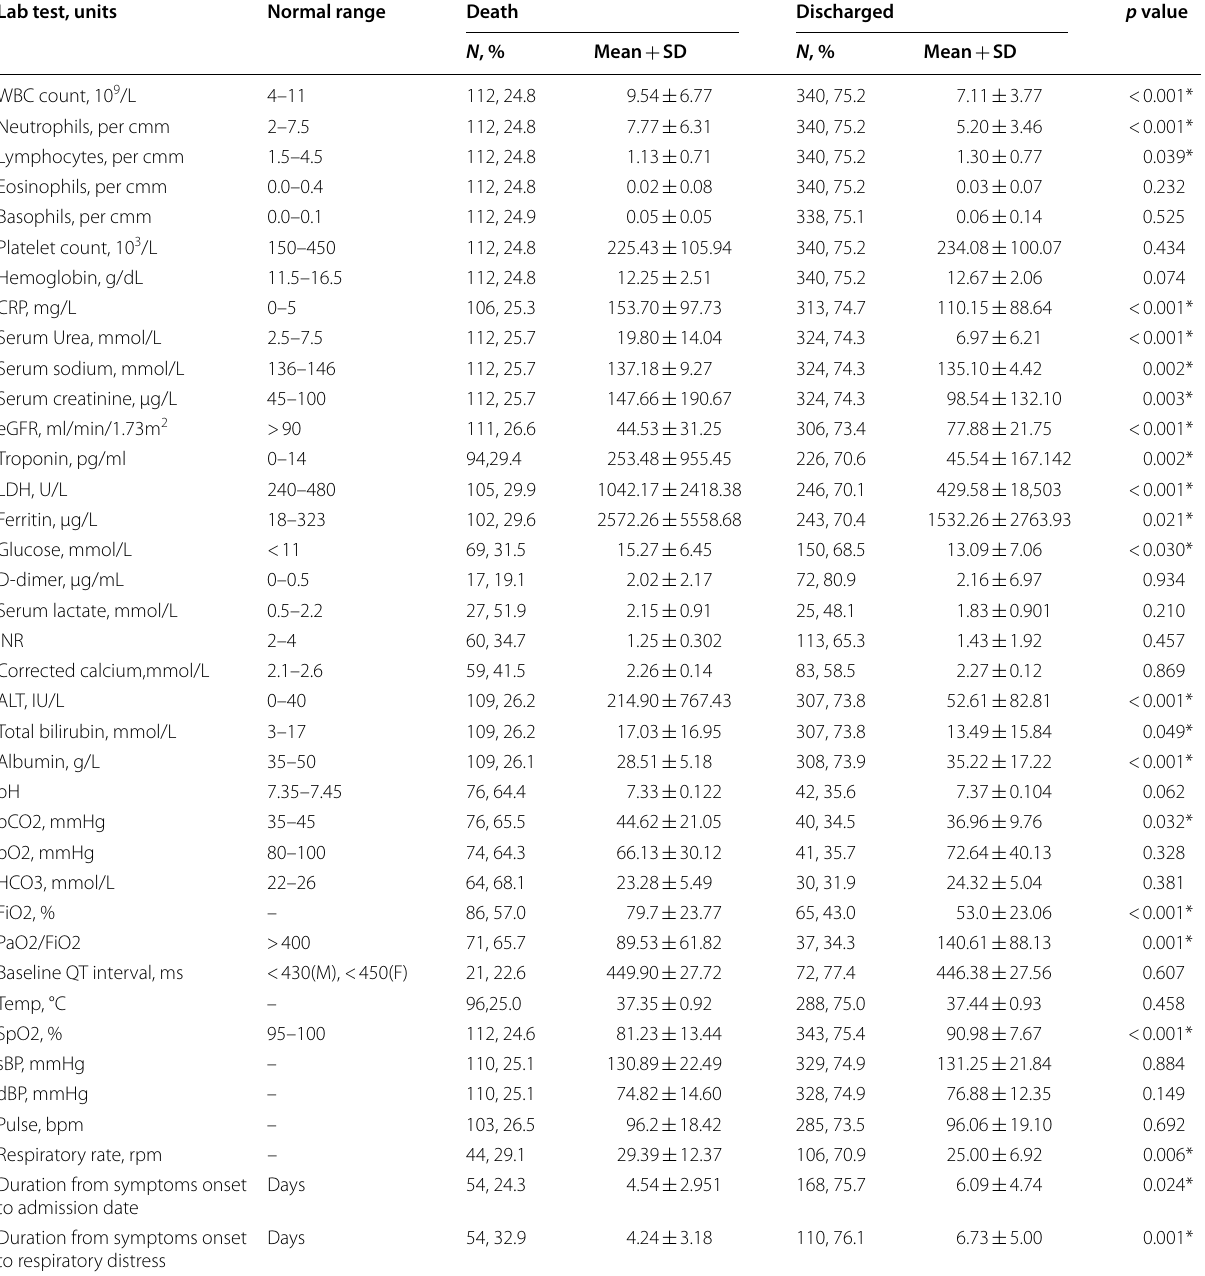
Table 3 Comparison of Laboratory parameters, vital signs and respiratory function indicators and outcome of hospitalised patients with